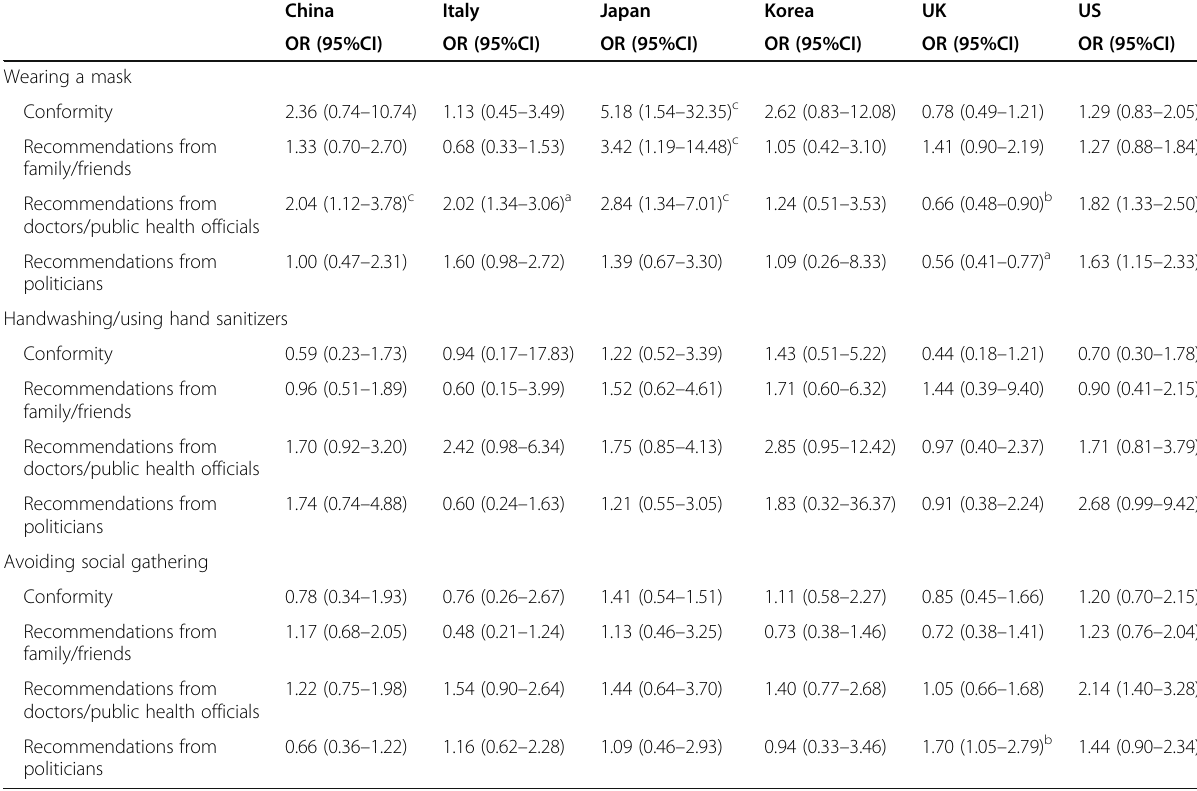
Table 6 Associations between conformity and recommendations from others and three preventive behaviors